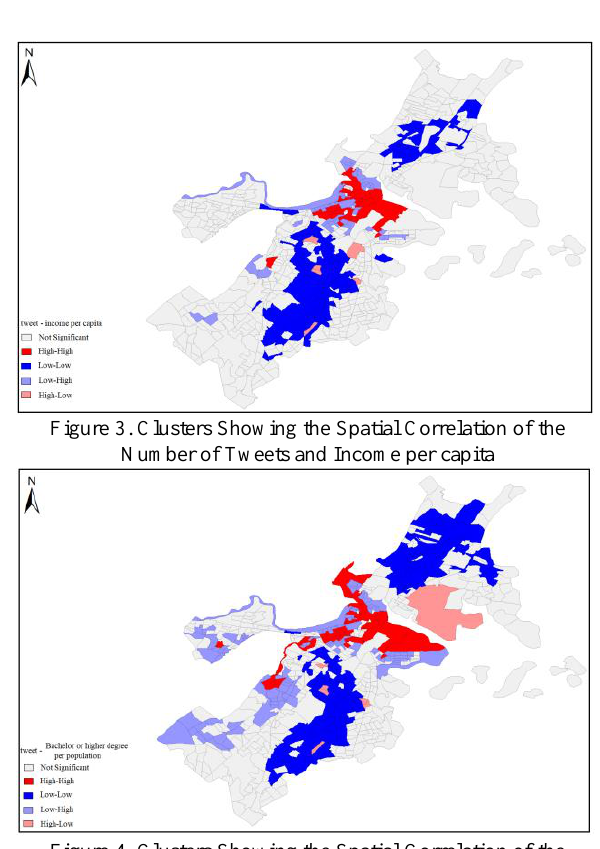
Figure 4. Clusters Showing the Spatial Correlation of the Number of Tweets and Number of People with a University